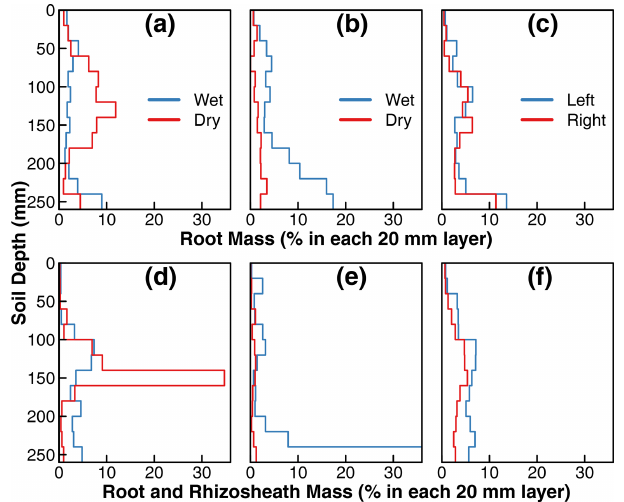
Figure 4. Incremental root mass distribution and distribution of to- tal mass of root and rhizosheath along the soil profile in treatments D (a, d) , C1 (b, e) , and C2 (c, f) . The root mass and total mass of root and rhizosheath within each interval was extracted and normal- ized to the total root or root and rhizosheath mass from the two iso- lated compartments. Each step in the plot represents the normalized mass distribution within the 20mm soil depth. Note: wet and dry compartments (compartments with 90% versus 10% water, respec- tively, in Fig. 1) were defined operationally to distinguish water sup- ply for treatments D and C1 mainly; in treatment C2, the water was supplied uniformly in the disconnected compartments, and they are labeled as left or right compartments. Detailed schemes of water and nutrient supply are provided in Fig. 1. In addition, we set the range of root mass distribution and distribution of total mass of root and rhizosheath within 0%–35% for proper visualization and consis- tency. However, the root and rhizosheath mass within 240–260mm in the wet compartment of treatment C1 accounted for ∼ 67% of the total distribution (e) , which was beyond the plotting range. De- tailed results of root and rhizosheath distribution are provided in the data set in the Supplement.